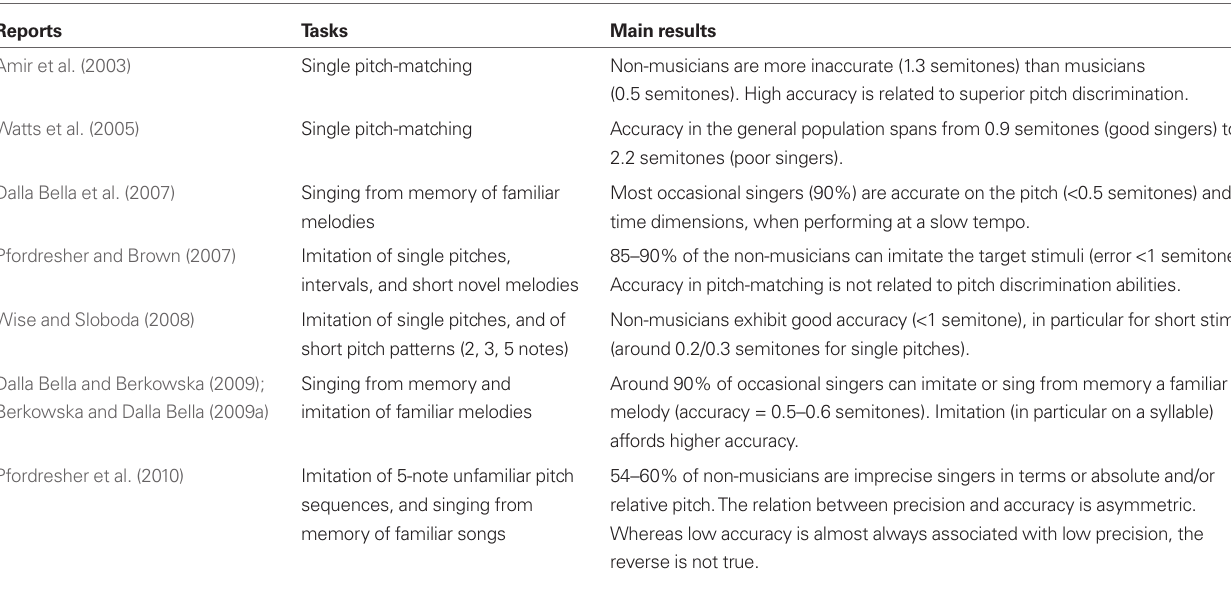
Table 1 | Summary of the main recent studies using acoustical measures of pitch accuracy and precision in normal individuals without musical